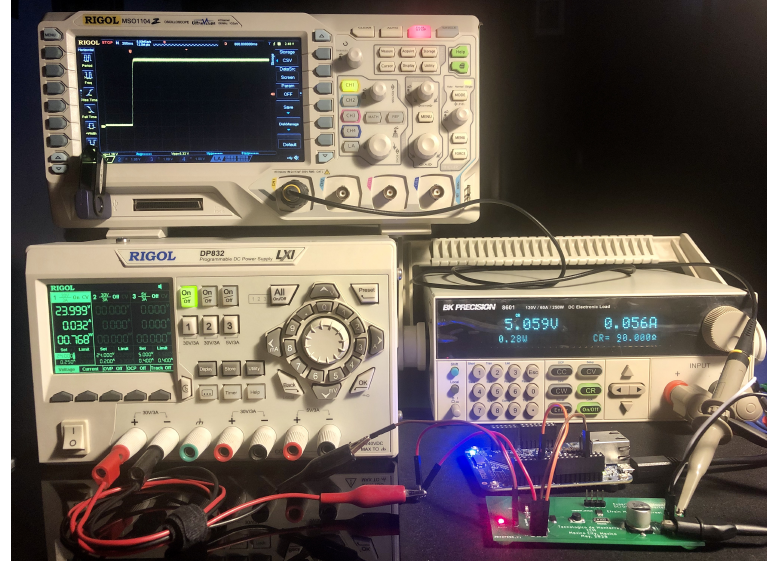
Figure 24. Precission output voltage against duty cycle